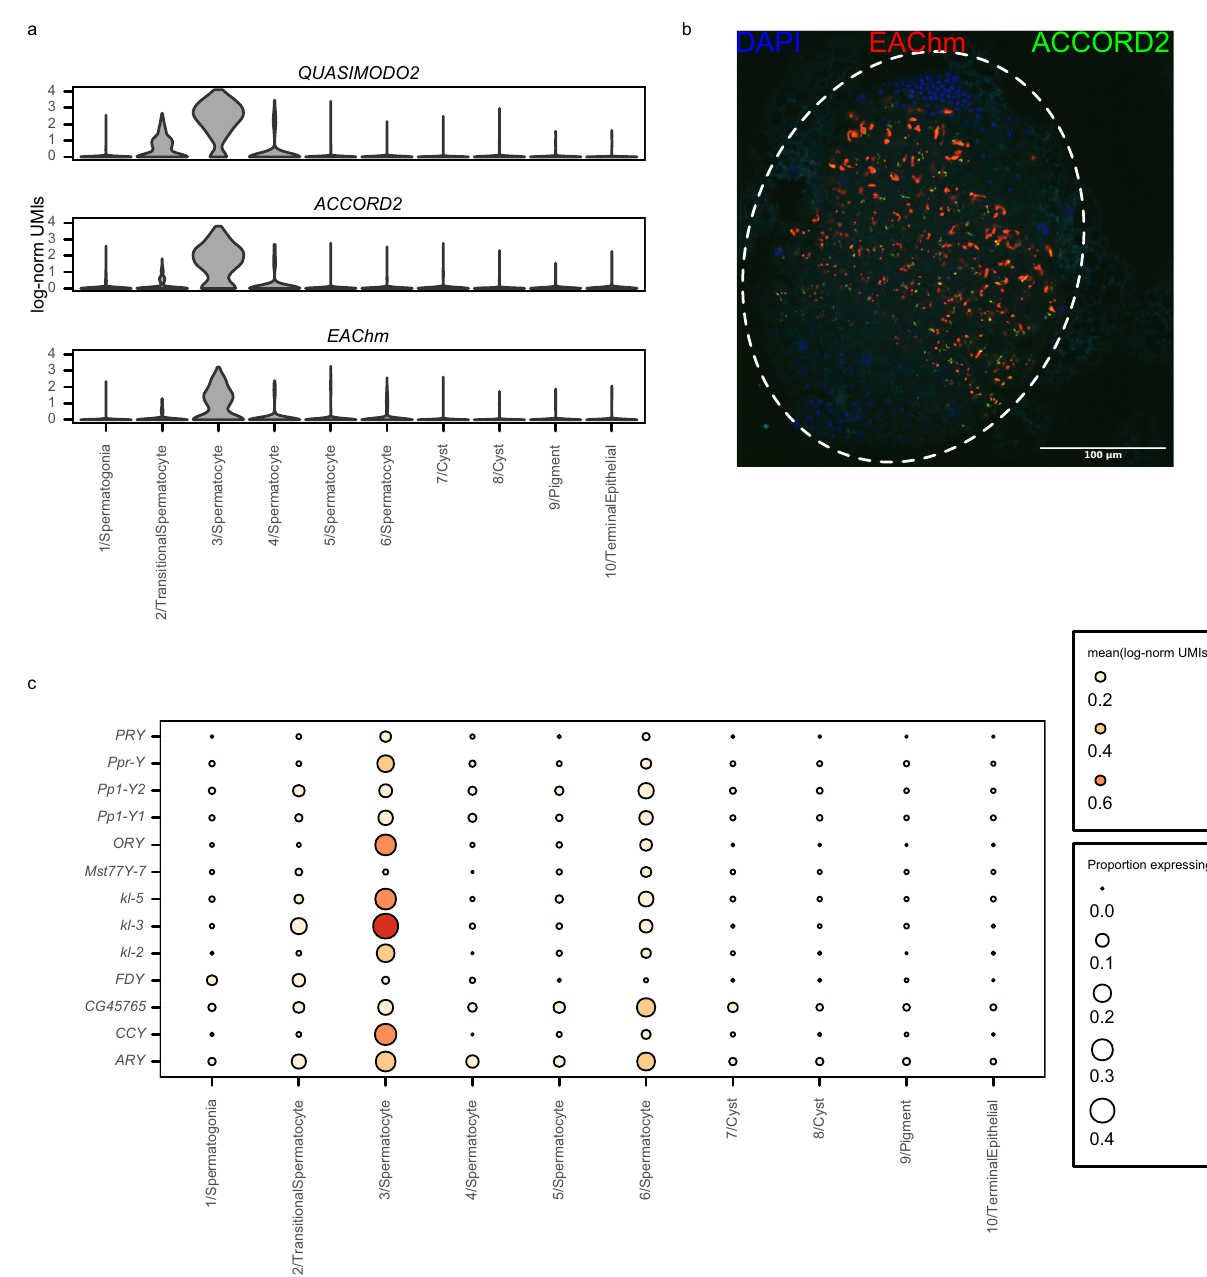
Fig. 4 Module 27 expression co-occurs with Y-chromosome transcriptional activity. a Violin plot shows that normalized expression of EAChm , QUASIMODO2 , and ACCORD2 is largely con fi ned to cluster 3/Spermatocytes. b Multiplexed RNA fl uorescence in situ hybridization (RNA-FISH) in whole- mount 3rd larval instar w1118 testis shows ACCORD2 and EAChm expression is detected in the middle region of the testis, where primary spermatocytes are located. Red: EAChm ; green: ACCORD2 ; blue: DAPI. Brightness and contrast were adjusted separately for each channel. Imaging was repeated in multiple testes with similar results. c Dot plot shows mean normalized expression of Y-linked genes in each cluster. Dot size corresponds to the proportion of cells in each cluster with detectable expression of each Y-linked gene. Y-linked genes, especially fertility factors kl-3 and kl-5 , are highly expressed by cluster 3/Spermatocytes. Source data are provided as a Source Data